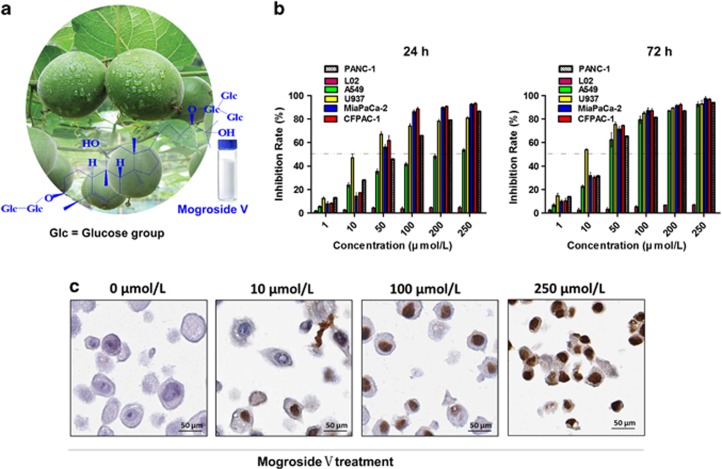
Mogroside V inhibits the proliferation and induces apoptosis in cultured cells. (a) Chemical structure of mogroside V extracted from S. grosvenorii. (b) Graph of MTT assay results indicating the rate of cell proliferation inhibition in PANC-1 and other tumor cell types treated with mogroside V. (c) Representative images of cells plated onto slides for TUNEL reaction apoptosis assays. The percentage of cells undergoing apoptosis increased with increasing mogroside V concentrations. The results were obtained in three independent experiments.